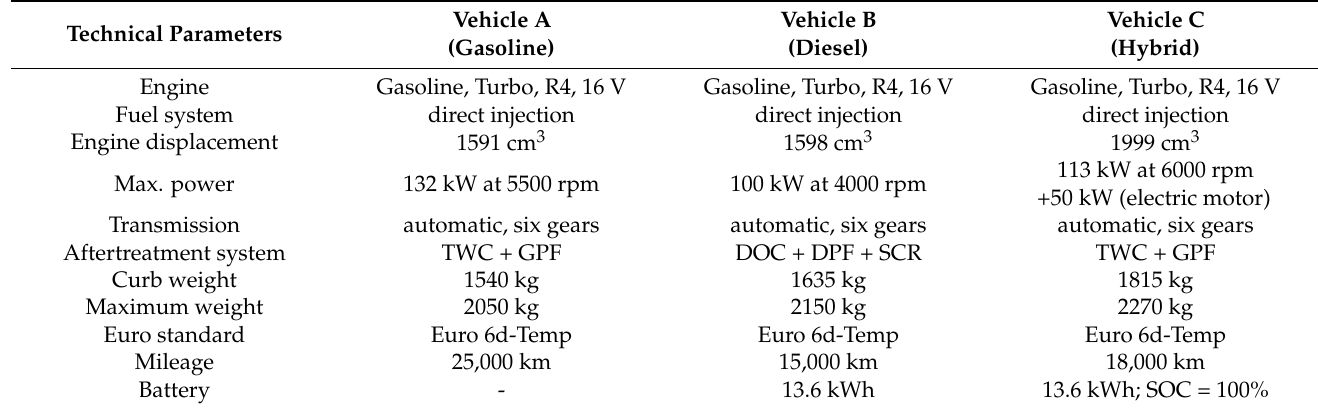
Table 1. Technical parameters of the tested passenger vehicles.